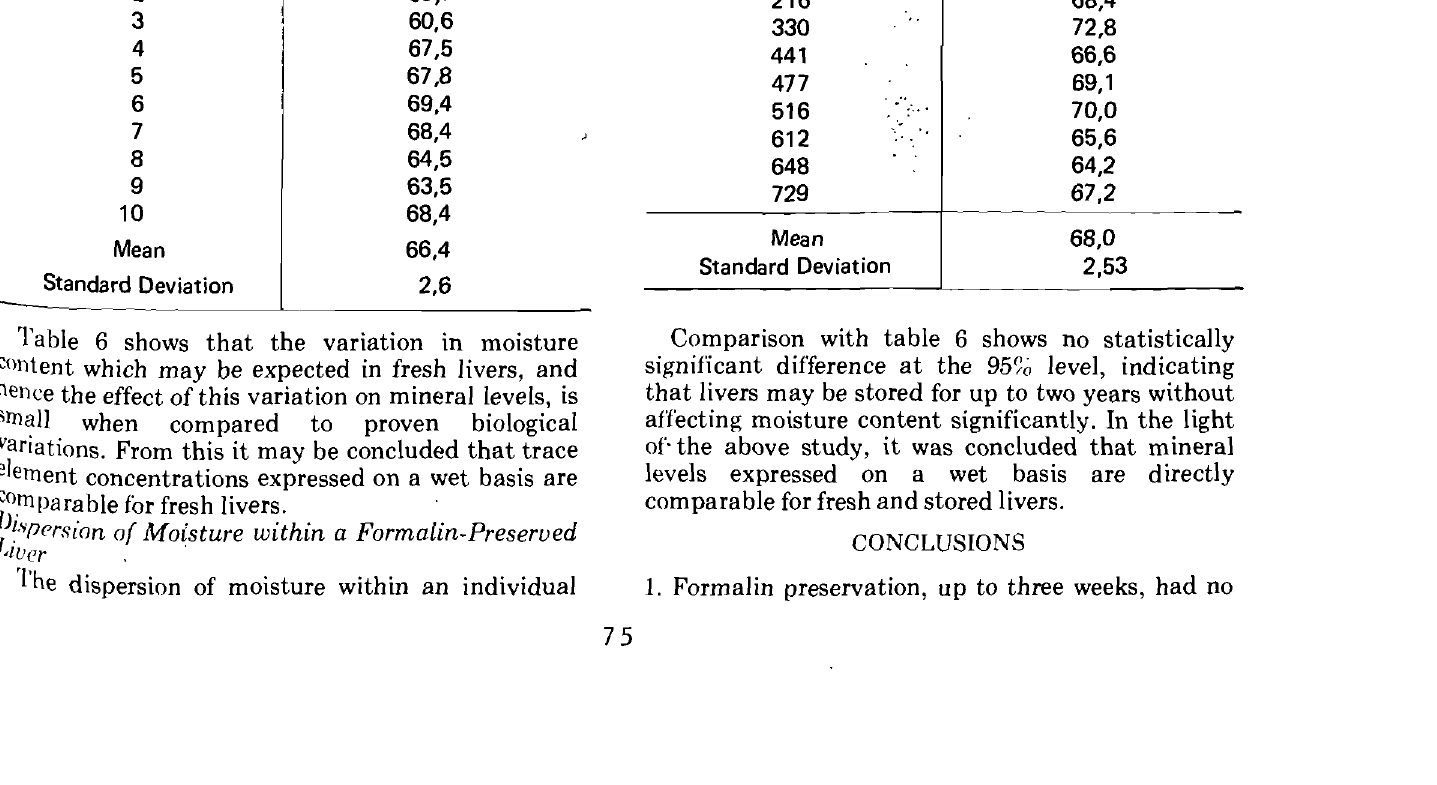
Table 8: MOISTURE CONTENT OF LIVERS